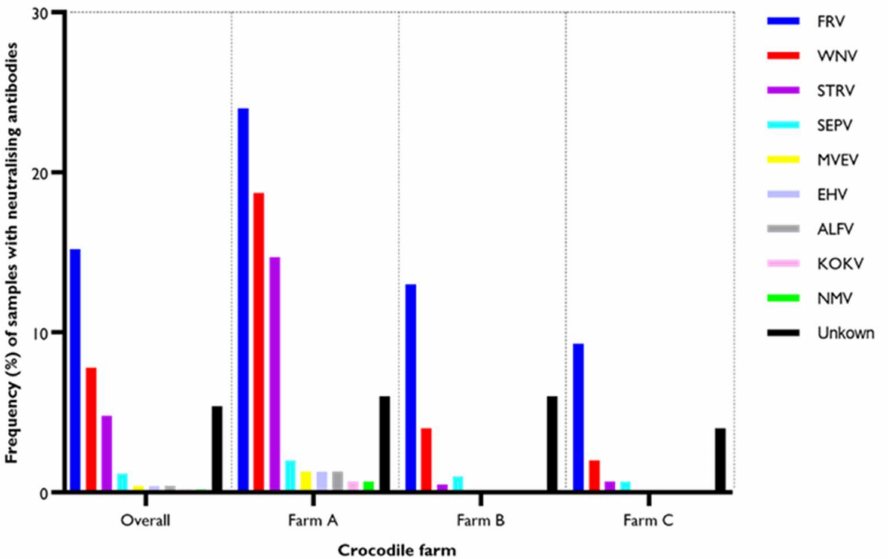
Figure 2. Proportion of samples that have neutralising antibodies against various viruses tested in the virus neutralisation assay. The overall frequency was determined based on the 500 samples collected from three crocodile farms. The frequency per farm was estimated based on n = 150 at Farm A, n = 200 at Farm B, and n = 150 at Farm C. Of the 130 samples positive in the 6B6C-1 blocking ELISA, 27 (20.8%, n = 130) did not have neutralising antibodies to any of the tested viruses. They were designated as unknown flaviviruses. Farm B had the highest number of animals positive for unknown flaviviruses ( n = 12), followed by Farm A ( n = 9) and Farm C ( n = 6) (Figure 3 and Table